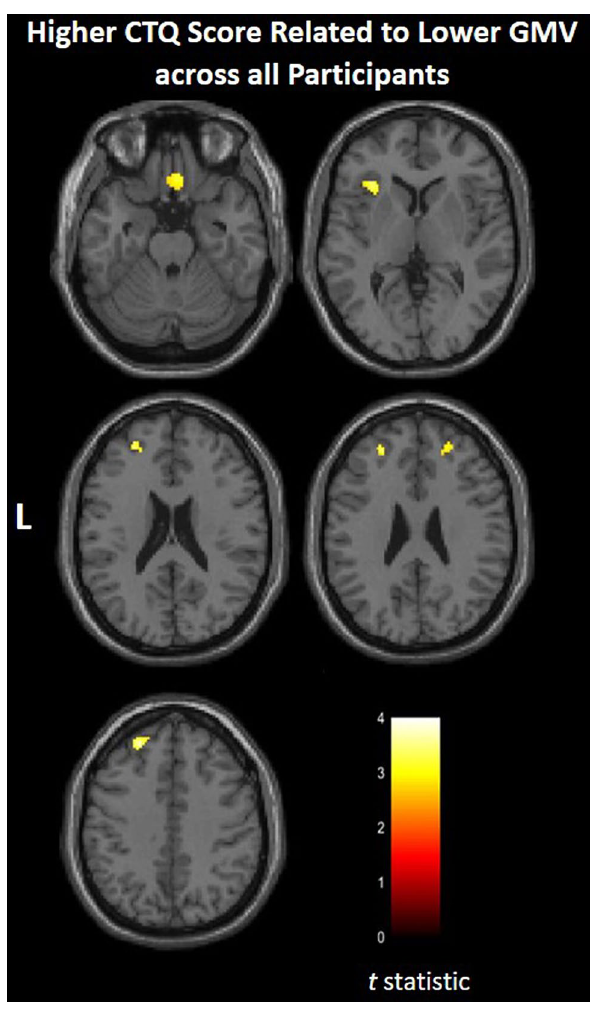
Figure 1. Areas of gray matter volume that related to childhood maltreatment. Axial-oblique images show regions where gray matter volume (GMV) inversely correlated with Childhood Trauma Questionnaire (CTQ) total scores across all participants [total N = 47; participants without a first-degree family member diagnosed with bipolar disorder (FH−): N = 26; participants with first-degree family member(s) diagnosed with bipolar disorder (FH+): N = 21]. Significance threshold is p < 0.005, uncorrected; clusters > 20 voxels. Left of figure denotes left side of brain. Color bar represents range of T